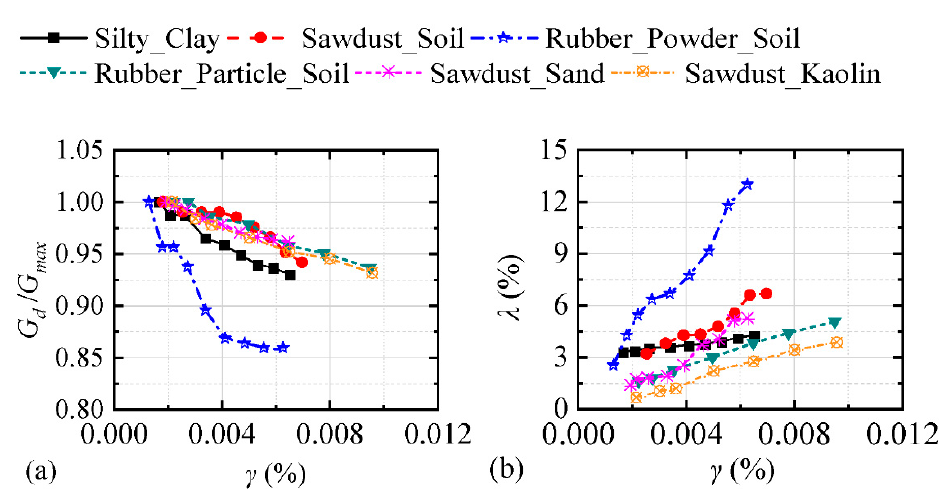
Figure 10. Comparison curve of dynamic characteristics between undisturbed soil and the five model soils when confining pressure was 100 kPa: ( a ) Normalized dynamic shear modulus, ( b ) Dynamic damping ratio.